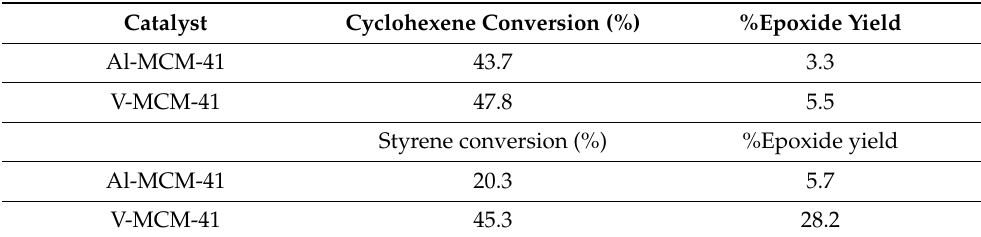
Table 2. Catalytic performance of VOTAP porphyrin incorporated in Al-MCM-41 and V-MCM-41 in cyclohexene and styrene oxidation